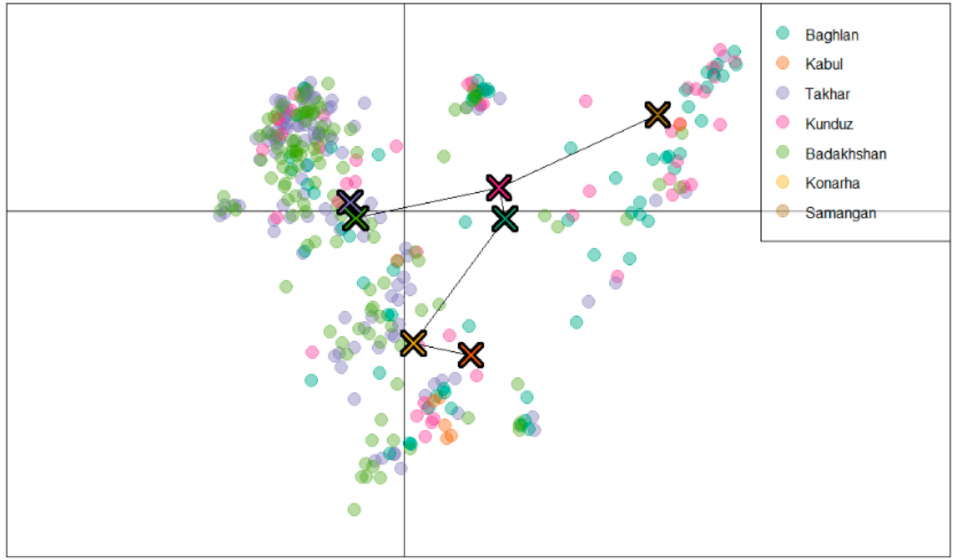
Figure 4. Inference of the sub-populations by discriminant analysis of the principal components (DAPC) analysis grouping landraces from different regions together.